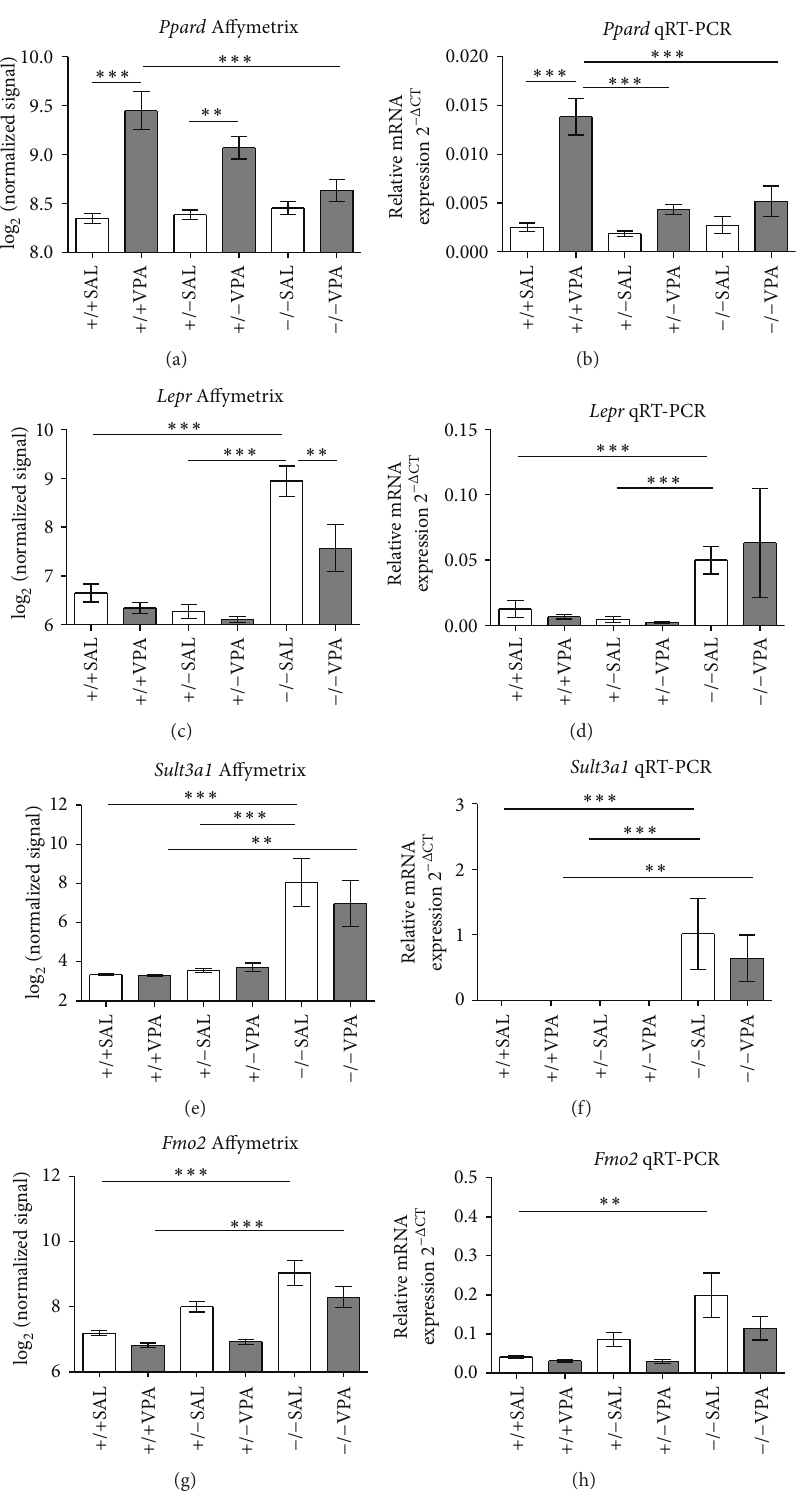
Figure 3: Comparison of results from Affymetrix GeneChip Mouse Gene 1.0 ST Array and qRT-PCR analysis. qRT-PCR mRNA expression is represented as the mean of quadruplicate per sample against the endogenous reference gene ACTB . (a) and (b) Ppard. Upregulation of Ppard by valproic acid (VPA) is abolished by Wfs1 invalidation. (c) and (d) Lepr. Lepr is upregulated in Wfs1 KO mice. (e) and (f) Sult3a1. Sult3a1 expression is increased in Wfs1 KO mice while downregulated by VPA. (g) and (h) Fmo2. Fmo2 expression level is increased in Wfs1 KO mice. All data are presented as means ± SEM ( 𝑛 = 8 ) and were compared by two-way analysis of variance (ANOVA) followed by Tukey’s post hoc test ( ∗∗∗ 𝑃 < 0.001 , ∗∗ 𝑃 < 0.01